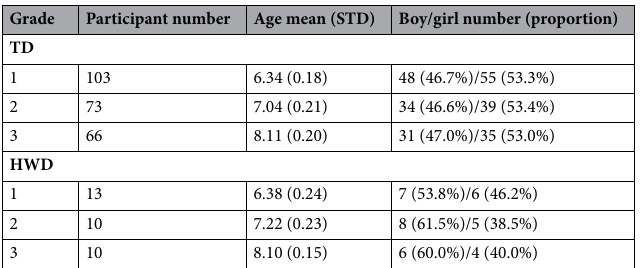
Table 1. Basic information and descriptive statistics of participants recruited for reliability and discriminative validity tests. TD Typically developing children, HWD Children with handwriting